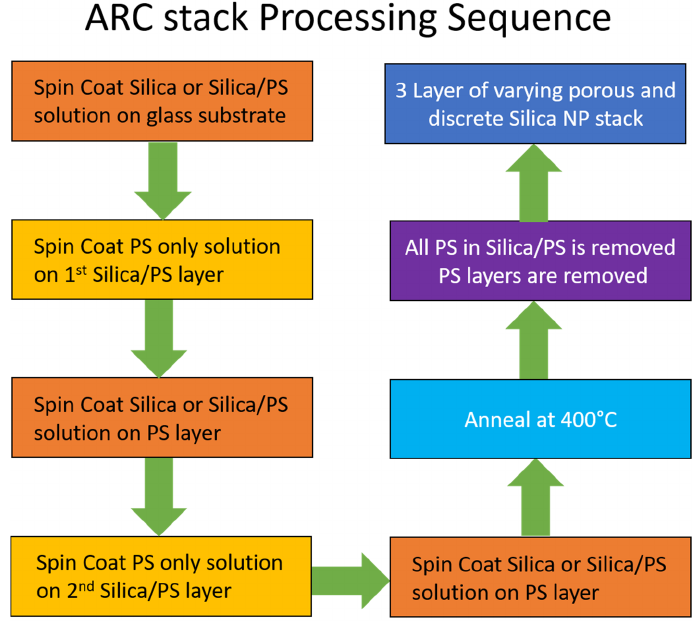
Figure 7. Sequence of steps to fabricate a discrete multilayer with graded refractive index.